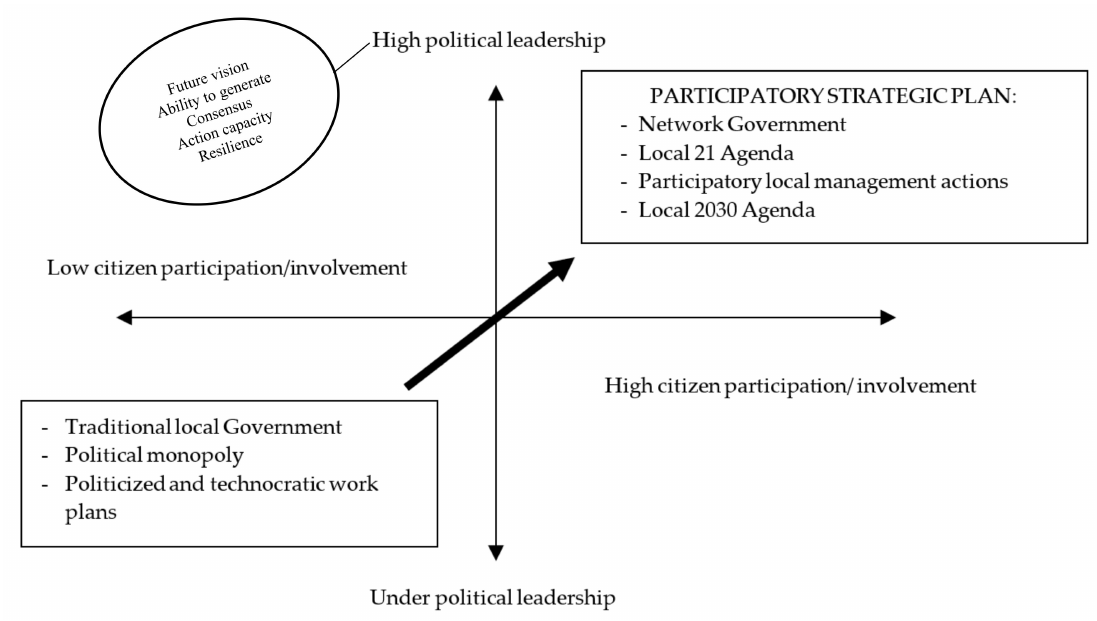
Figure 2. Network Government (authors’ elaboration from the work of Font, 2001 [46]).